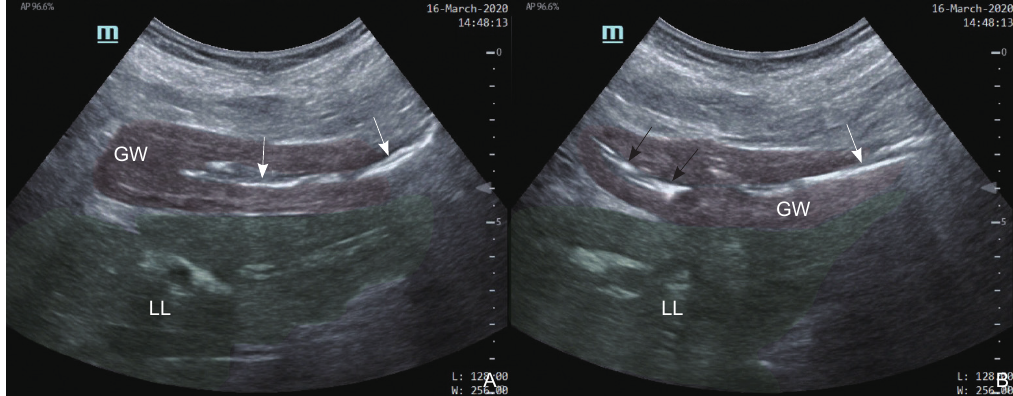
Figure 2 In sub-sternum transversal plane, gastric wall (GW) and gastric mucosa (White arrow) can be observed clearly (A, B), and presence of air bubbles (Black arrow) after tentatively air injection confirmed the appropriated location of nasogastric tube (B). GW, gastric wall; LL, left